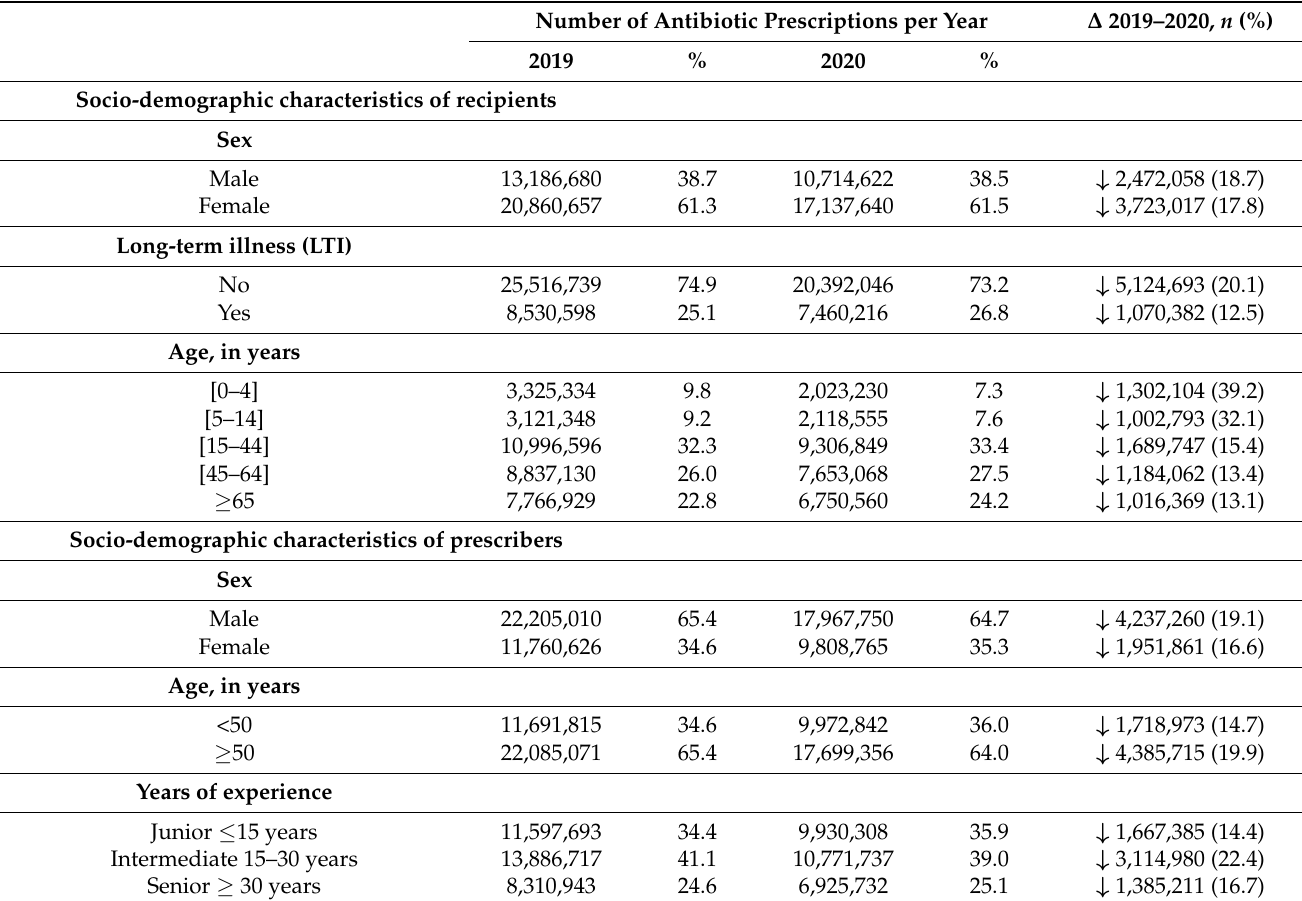
Table 3. Distribution of prescriptions according to some socio-demographic characteristics of recipi- ents and prescribers and therapeutic classes of antibiotics, 2019 and 2020,